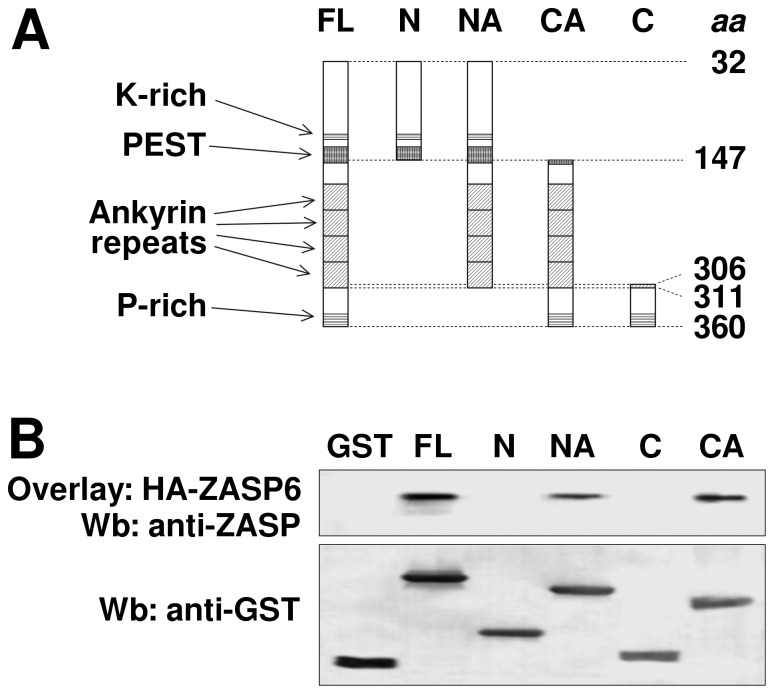
ZASP6 interacts with the ankyrin repeat region of Ankrd2.
A) is a schematic diagram showing the different regions of Ankrd2 used in this experiment. The Ankrd2 numbering refers to the canonical Ankrd2-202 sequence (ENSEMBL); FL refers to the full-length of Ankrd2-001 (Kojic et al., 2004). There are four ankyrin repeat motifs in the human Ankrd2 protein between aa 148–308, a PEST sequence that targets proteins for proteolytic cleavage, as well as regions rich in amino acids lysine (K) and proline (P). B) GST-overlay assay demonstrating that NA and CA regions of Ankrd2 contain the binding site/sites for ZASP6. GST-FL-Ankrd2, GST-N-Ankrd2, GST-NA-Ankrd2, GST-CA- Ankrd2, GST-C-Ankrd2 and GST alone were separated by SDS-PAGE and blotted. The membrane was blocked and then overlaid with lysate from COS-7 cells transfected with pcDNA3-HA-ZASP6. The membrane was probed with an anti-ZASP mouse polyclonal antibody. The Western blot in the lower panel shows that equal amounts of the GST proteins were used in this experiment.